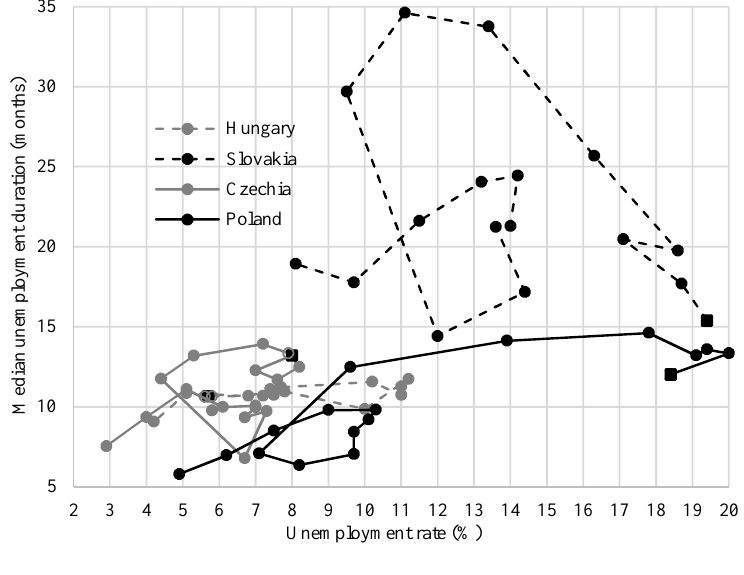
Figure 3. Relation between the unemployment rate and the median unemployment duration for the Visegrad Group countries in years